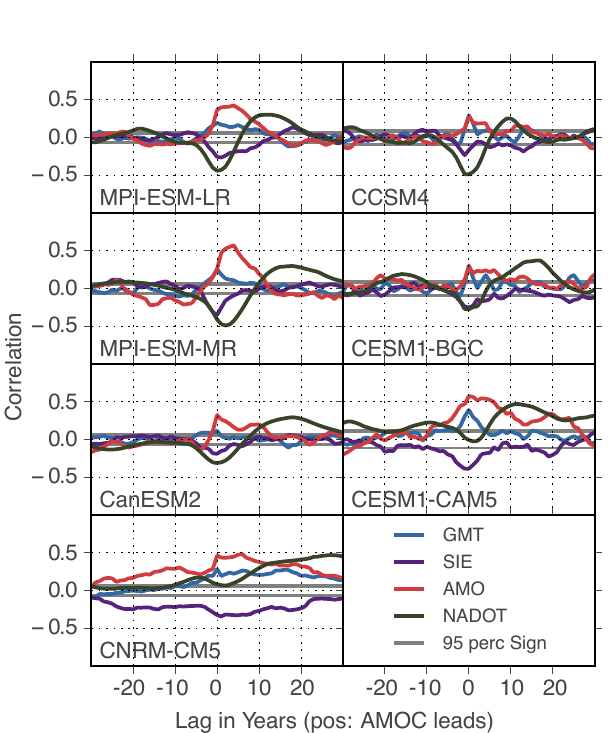
Fig. 3. Cross-correlations between AMOC and GMT, SIE, NADO Fig. 3. Cross correlations between AMOC and GMT, SIE, NADO temperature and the AMO index (positive: AMOC leads). The grey lines temperature and the AMO index (positive: AMOC leads). The grey mark the two-tailed 95 % significance range. lines mark the two-tailed 95% significance